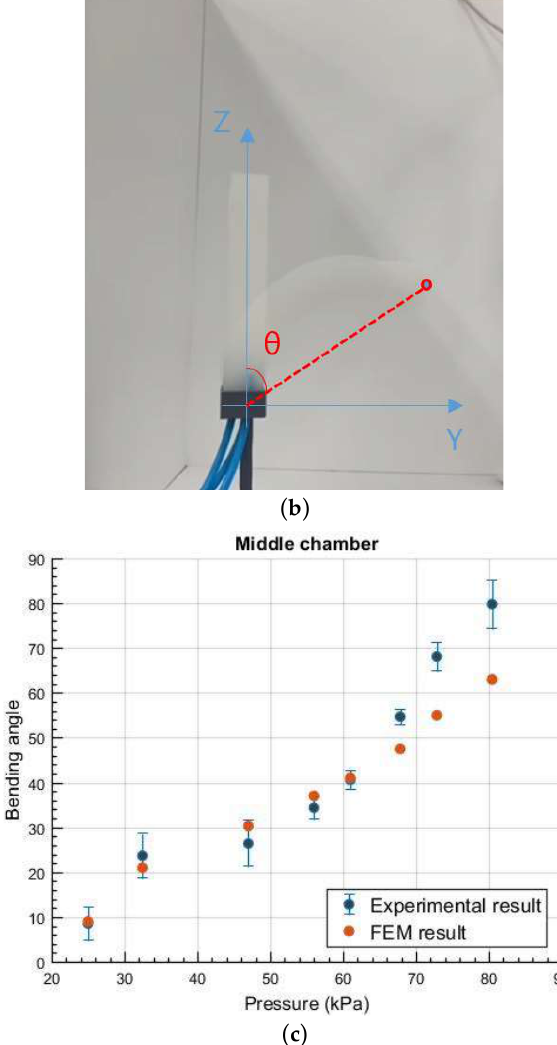
Figure 8. Experiment on single finger: ( a ) Experimental setup; ( b ) bending angle when the middle chamber is inflated; ( c ) plot showing the relationship between bending angle and pressure with middle chamber’s inflation.